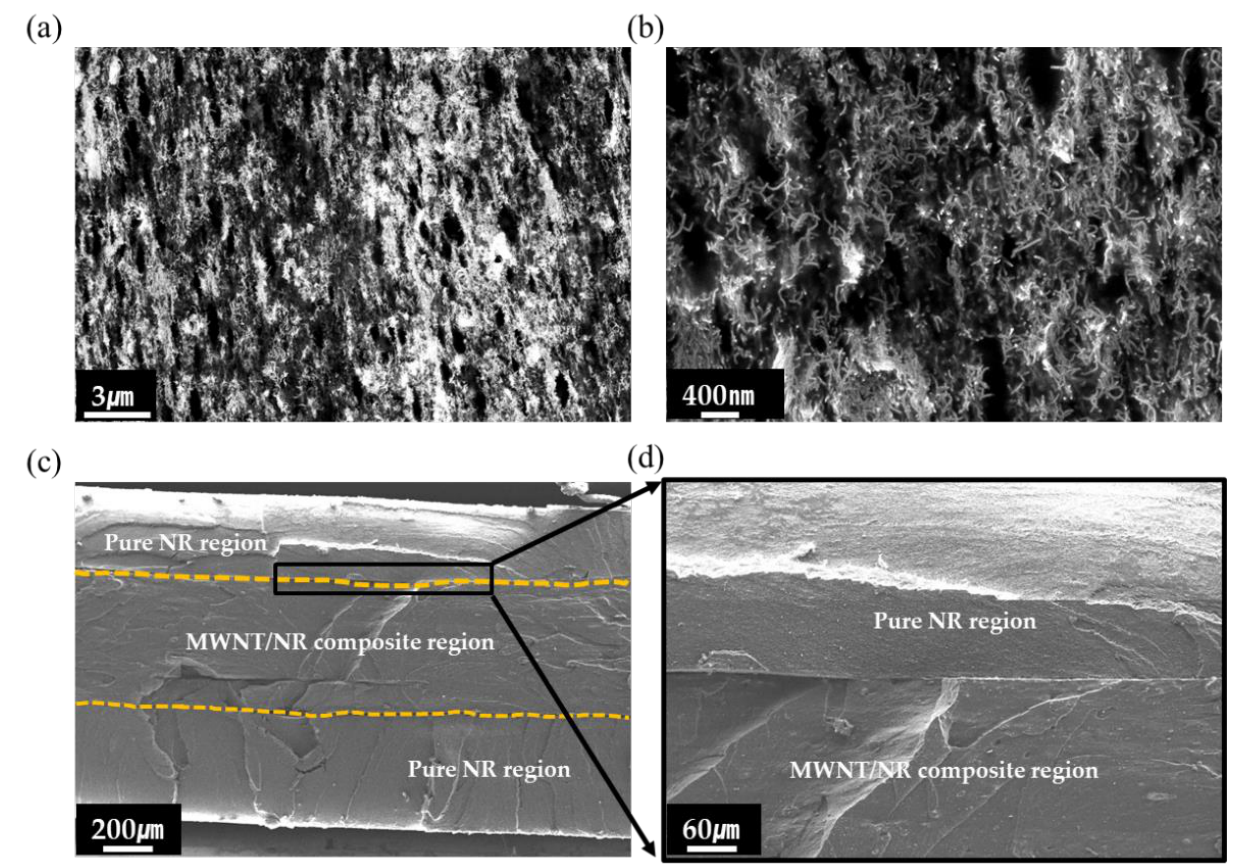
Figure 2. SEM image of cryo-fracture surface of 5 wt.% MWNT/NR composite: ( a ) low magnification, and ( b ) high magnification. Cross-section view of hybrid structure: ( c ) low magnification, and ( d ) middle magnification.